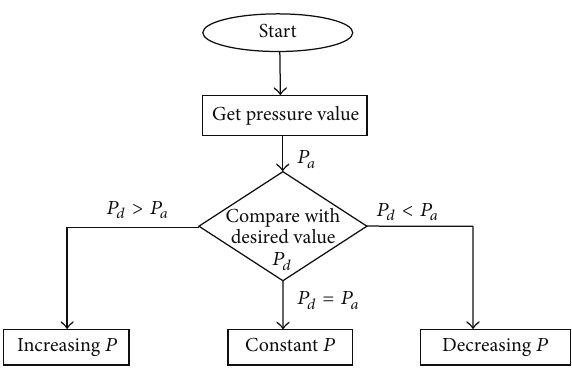
Figure 14: Flow chart of control